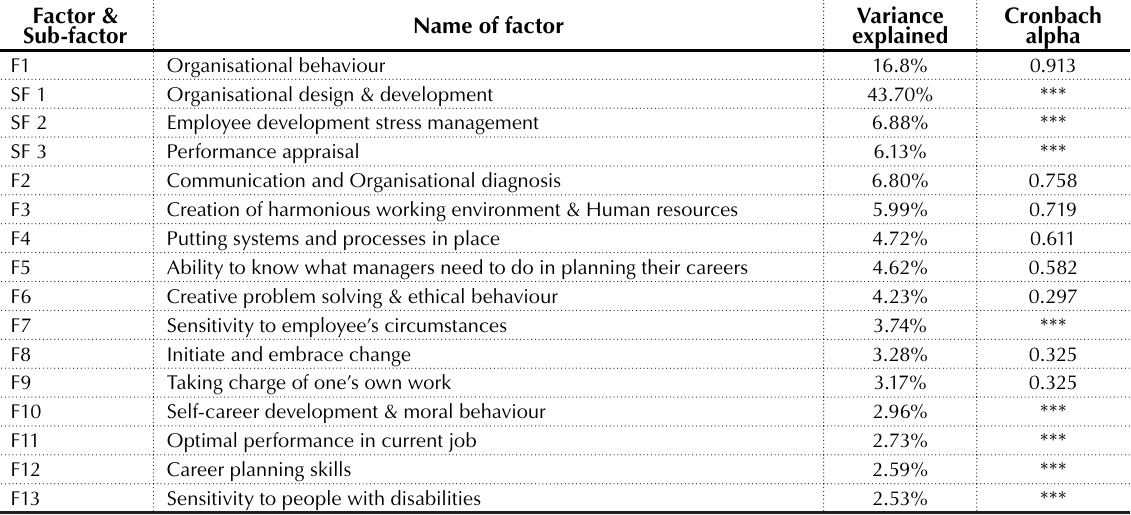
Table 1. Thekiso’s factors of managerial